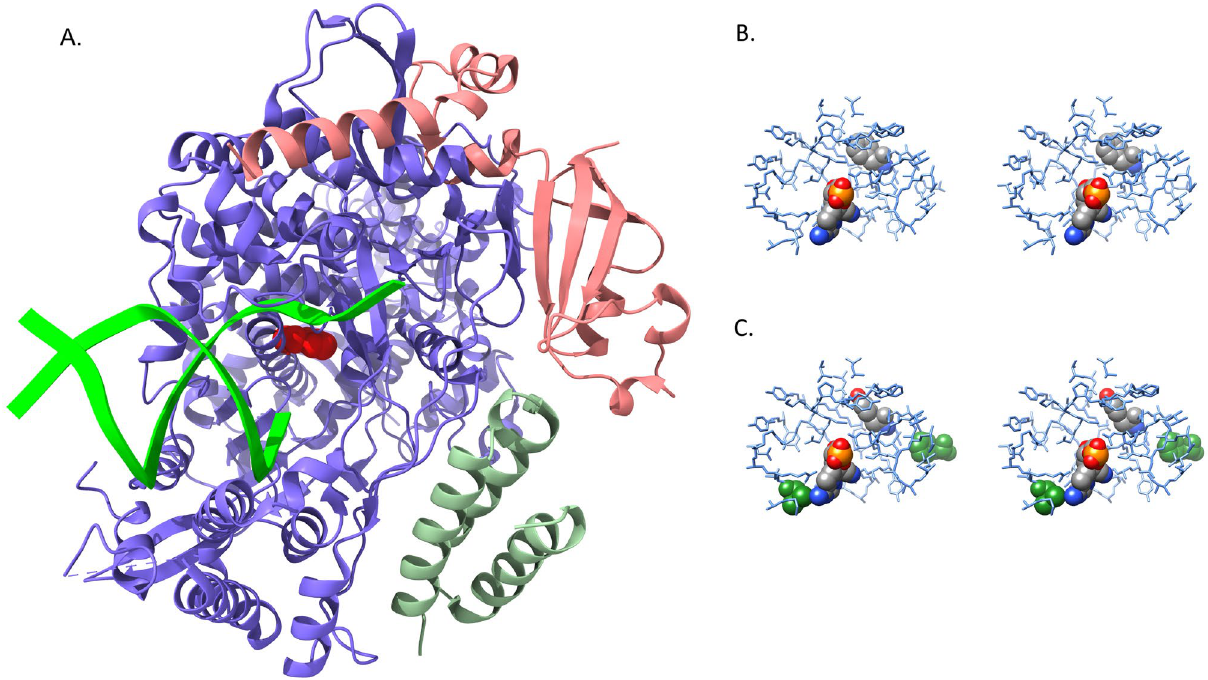
Figure 8. ( A ) RNA-dependent RNA polymerase (blue) complex formed with non-structural protein 7 (green) and non-structural protein 8 (salmon). Primer and template RNA strands (lime green) are depicted as ribbons extending from the active site. The mutated residue (F694Y) is rendered as a red CPK model. ( B ) Stereo pair view of the active site with bound remdesivir molecule. Both remdesivir and F694 are rendered as CPK models, and their atoms are color-coded by atom type as described in Fig. 5. ( C ) Stereo pair view of active site with bound remdesivir in the F694Y mutant. Residues F480 and V557, which impart inhibitor resistance in SARS- CoV-1 polymerase, are rendered as green CPK models to illustrate their locations relative to remdesivir. F480 is on the right side of the image and V557 is in the lower left region. The orientation and color-coding are identical to that in Fig. 8B. The mutant homology model has not been subjected to further structural refinement and this image clearly displays steric clashes generated by substitution of the tyrosine side chain. Models in panels A, B and C are all based on the cryo-electron microscopy structure PDB ID: